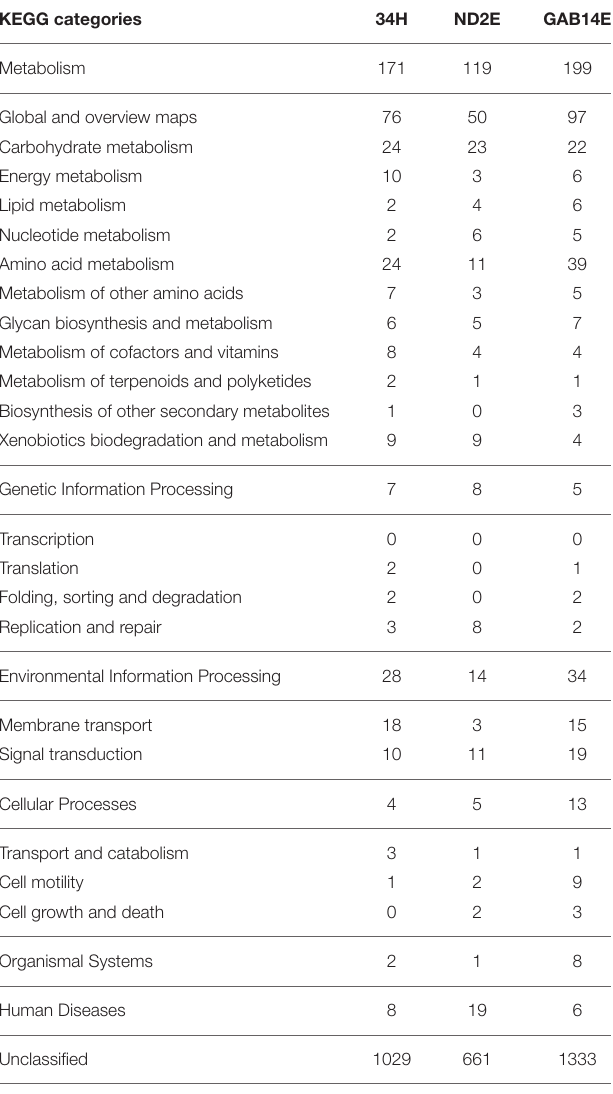
TABLE 2 | KEGG categories for strain-specific genes from each of the three